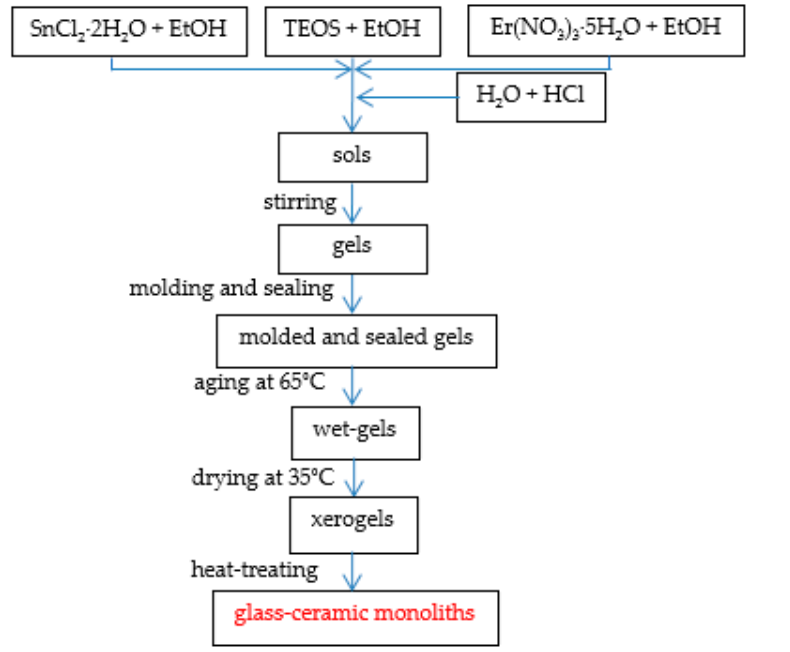
Figure 1. The flow-chart illustrating the synthesis procedure of 90SiO 2 -10SnO 2 :0.5Er 3+ monoliths.